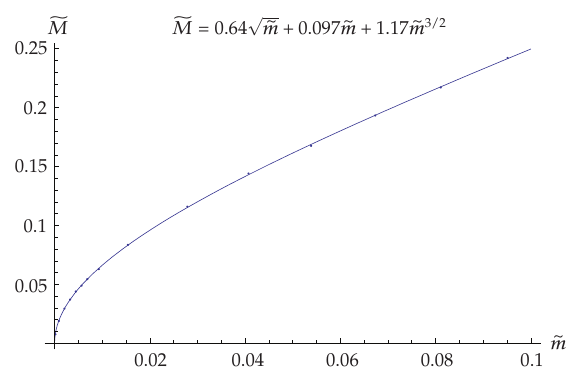
√ 6 (cid:5) m behavior at small bare quark M ∝